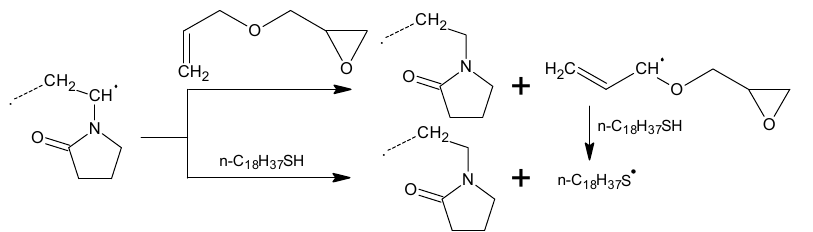
Scheme 2. Chain transfer during the copolymerization of N-vinyl-2-pyrrolidone and allyl glycidyl ether in the presence of n-octadecylmercaptan .